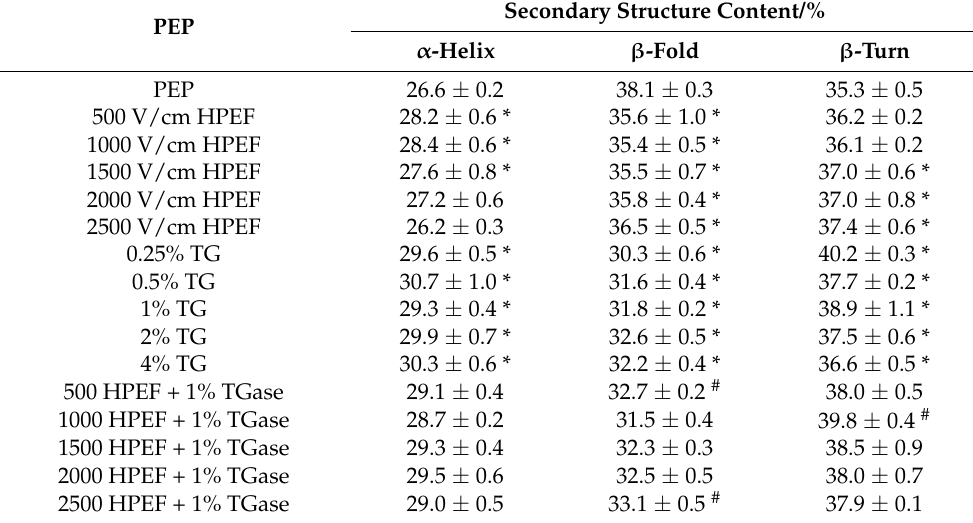
Table 1. The effect of HPEF (500, 1000, 1500, 2000, and 2500 V/cm) addition, TGase (0.25, 0.5, 1, 2, and 4%), and compound treatment (HPEF-500, 1000, 1500, 2000, 2500 V/cm; 1% TGase) on the secondary structure of PEP.